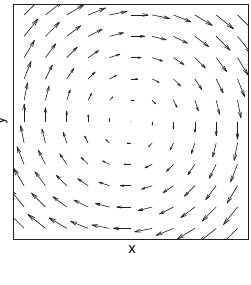
FIG. 5. Pretest field 2.